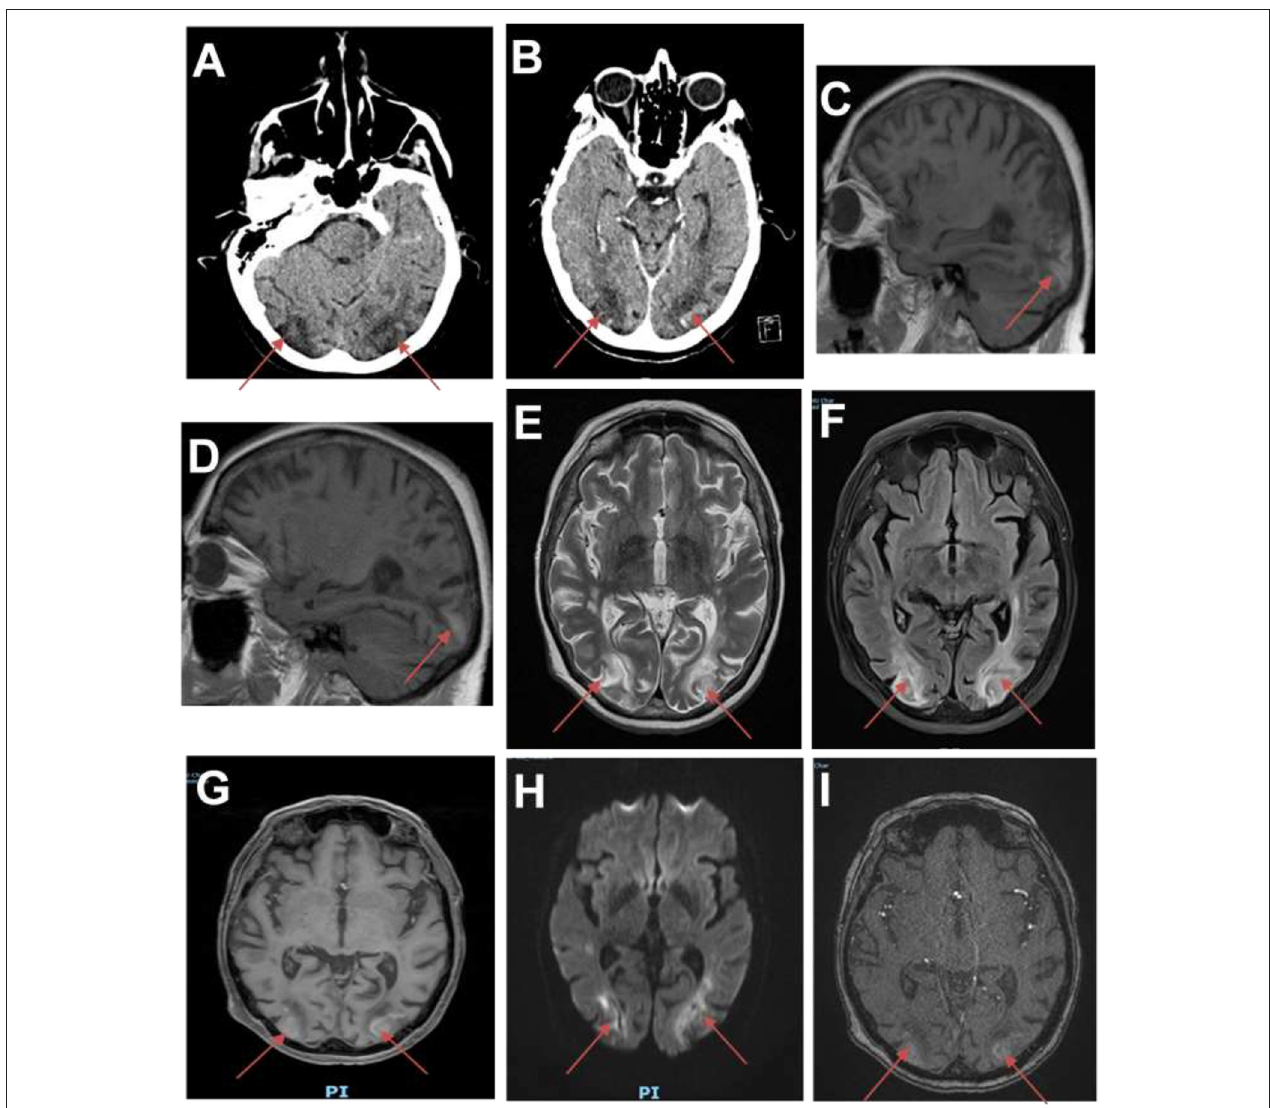
FIGURE 1 | First brain imaging. (A) Brain CT showing ischemic-like lesions in the occipital lobes (red arrows). (B) CT scan showing hypodense lesions with breakdown of the blood–brain barrier (BBB) in the occipital lobes. (C,D) Sagittal T1 MRI showing hyperintensities in both occipital lobes. (E) Brain MRI (T2-weighted images) showing hyperintense lesions in the white matter of the occipital lobes. (F) Fluid attenuation inversion recovery (FLAIR) images showing ischemic-like lesions in the occipital lobes. (G) MRI angiographic sequences showing breakdown of BBB in the occipital lobes. (H) Diffusion sequence showing restriction in the occipital lobes. (I) Magnetic resonance angiography time-of-flight (MRA TOF) sequences showing breakdown of BBB in the occipital